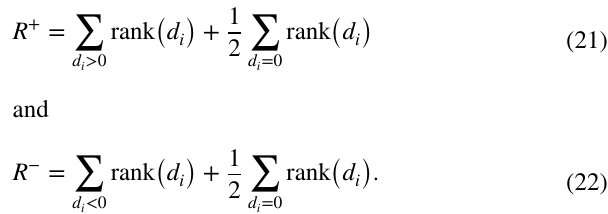
− the sum of ranks